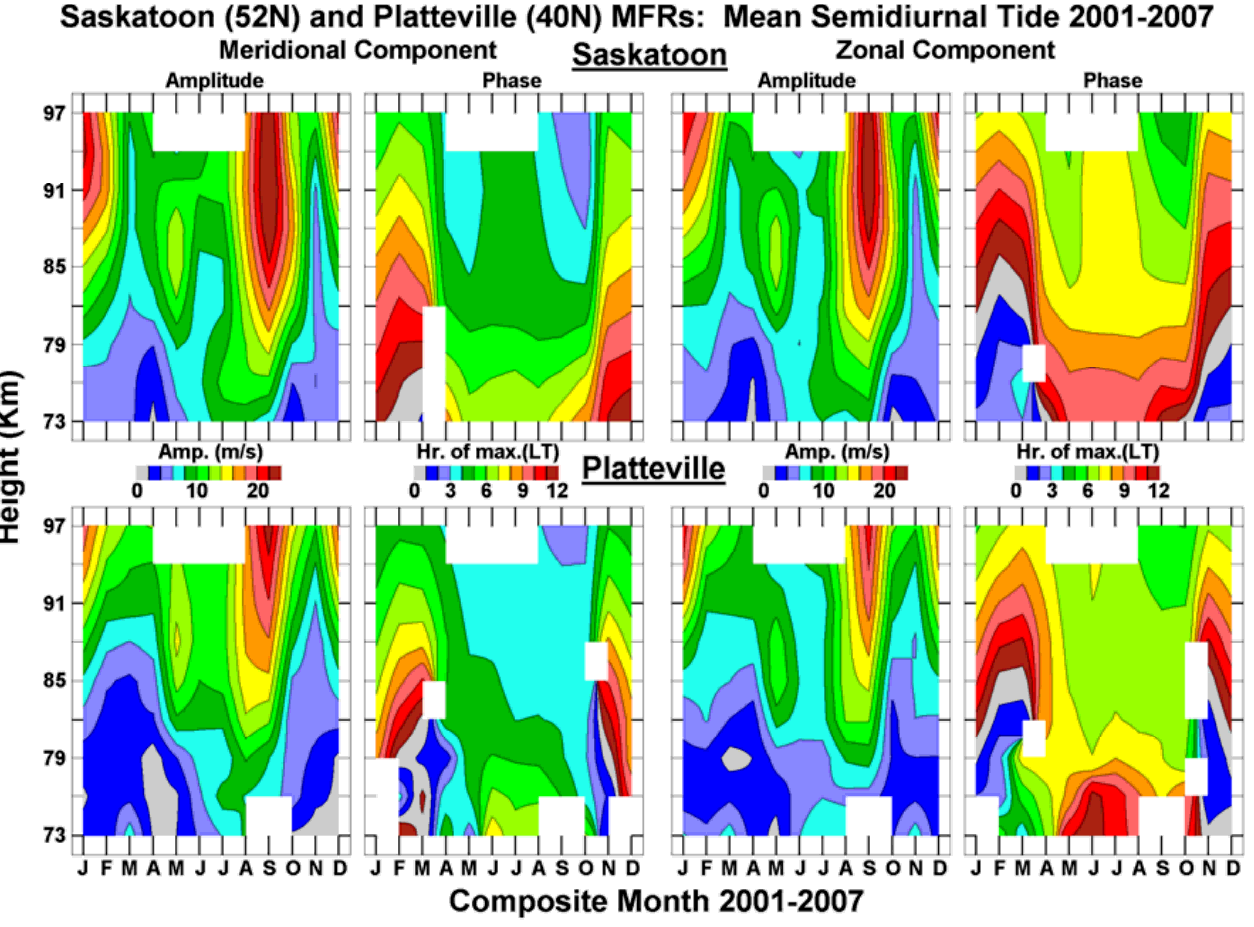
Fig. 1. Contour-plots of amplitudes and phases of the semidiurnal tide [meridional and zonal wind components] as functions of height and time: Data from Saskatoon and Platteville for the years 2001–2007 have been